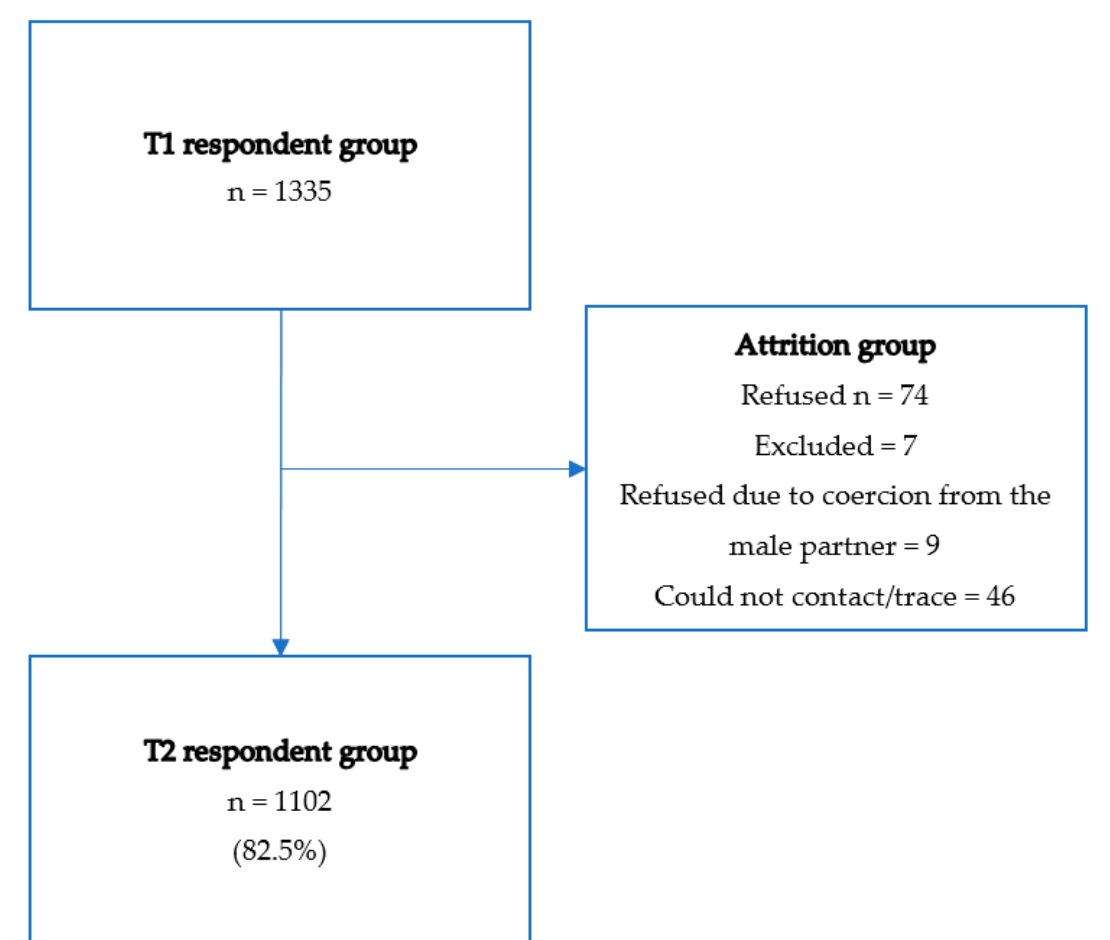
Figure 1. Flow diagram of inclusion and attrition. Table 2. Influenza-Like Illness in pregnancy in relation to trauma, IPV, depression and